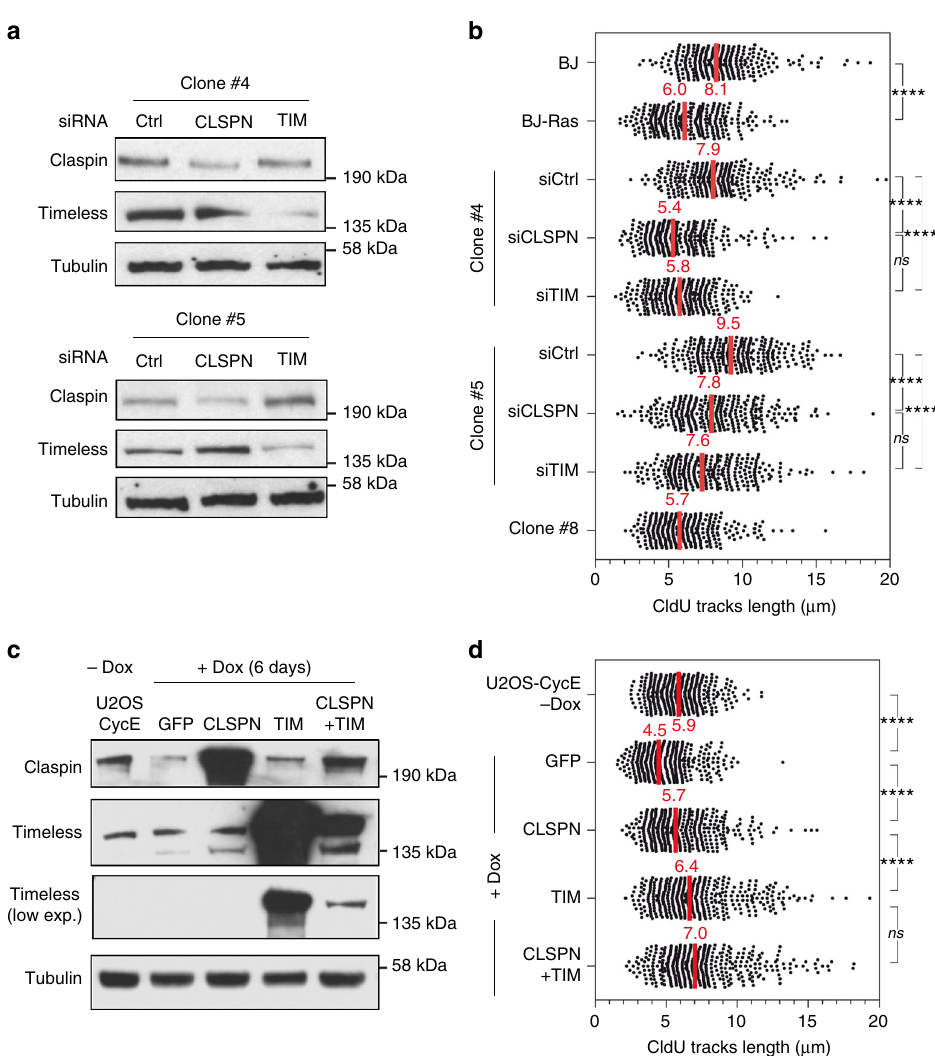
Fig. 6 Increased levels of Claspin and Timeless promote fork progression in cells expressing oncogenic Ras. a Protein levels of Claspin and Timeless in clones #4 and #5 transfected with control (si-Ctrl), Claspin (si-CLSPN), and Timeless (si-TIM) siRNAs. b DNA fi ber spreading analysis of fork progression in clones #4 and #5 after depletion of Claspin and Timeless with siRNAs. Median CldU tracks length (red) were determined for three independent experiments. **** p < 0.0001, *** p < 0.001, ns nonsigni fi cant difference. Mann – Whitney rank sum test. c Levels of Claspin and Timeless in U2OS-CycE cells transfected with GFP, Claspin, and Timeless plasmids. U2OS-CycE cells expressing Cyclin E under the control of a doxycyclin-inducible promoter were grown during 6 days in the presence of Dox to induce replication stress. Then cells are transfected with plasmids to overexpress GFP, Claspin or Timeless during 3 days before performing DNA spreading experiment. d DNA spreading analysis of experiment performed in c . DNA spreading was also performed on U2OS-CycE cells growing without Dox. Median CldU tracks length (red) were determined for three independent experiments. **** p < 0.0001,